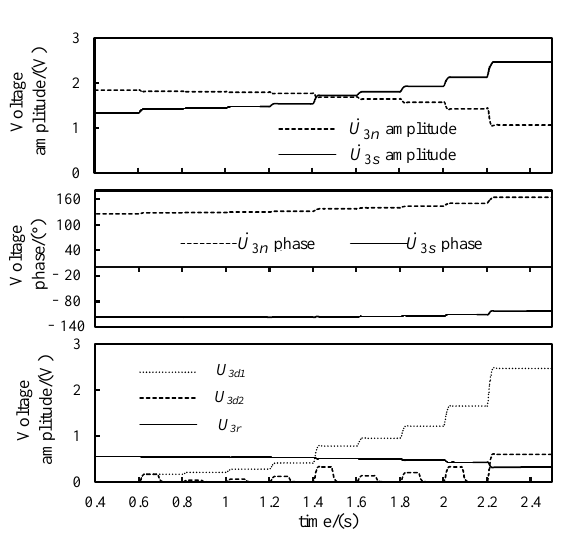
Figure 10. Trip calculation when a generator’s neutral point is grounded via a varied resistor.